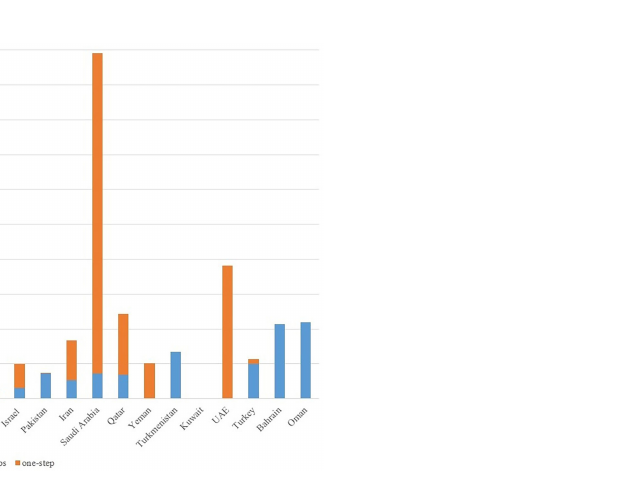
FIGURE 3 | GDM screening steps with GDM prevalence in Asian studies. Due to the homogeneity of Chinese population residing in China, Taiwan and Hong Kong, we reported the country-speci fi c prevalence of these three regions as a